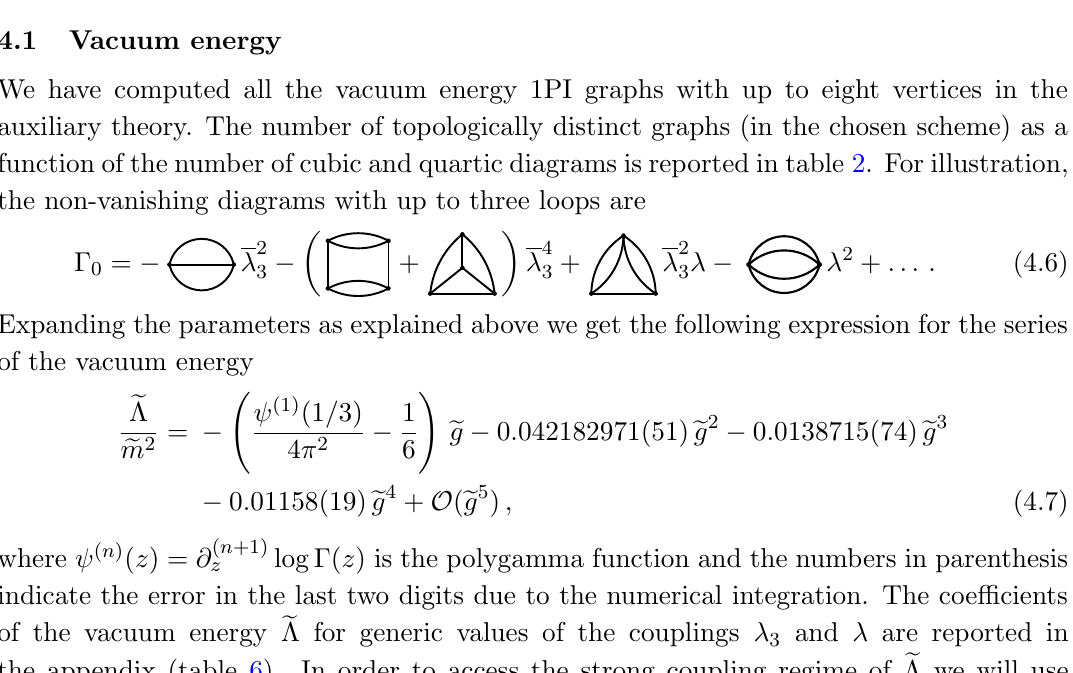
Table 2 . Number of topologically distinct 1PI 0-pt diagrams without self-contractions with maxi- mum eight total vertices for the auxiliary